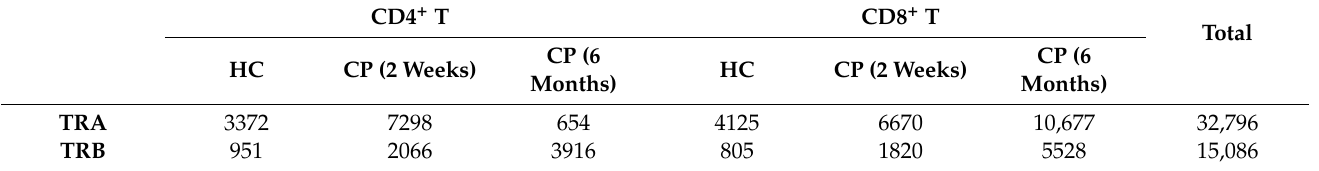
HC, healthy controls; CP (2 weeks), COVID-19 patients with 2-week convalescence phase; CP (6 months), COVID-19 patients with 6-month convalescence phase; TRA, T cell receptor α chain; TRB, T cell receptor β